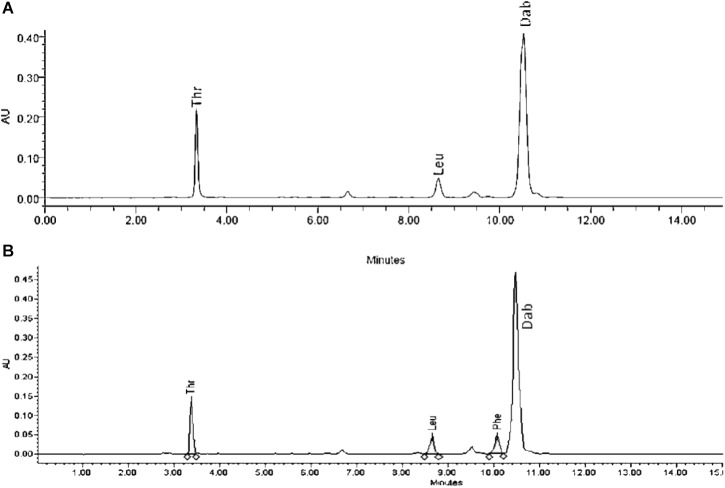
Amino acid analysis of P2 (A) and polymyxin B (B).